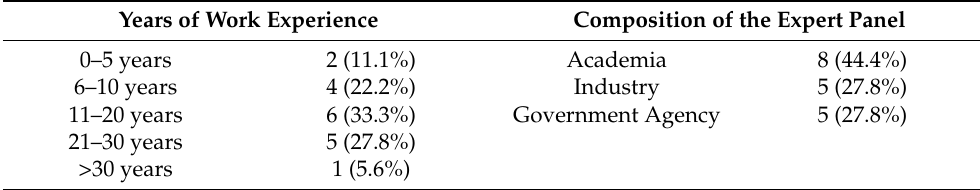
Table 2 details the work experience of the experts and the percentages of attendees in each group of experts (academia, industry, and government agency). Table 2. Demographic information and percentage composition of the panel. Table 2. Demographic information and percentage composition of the panel.